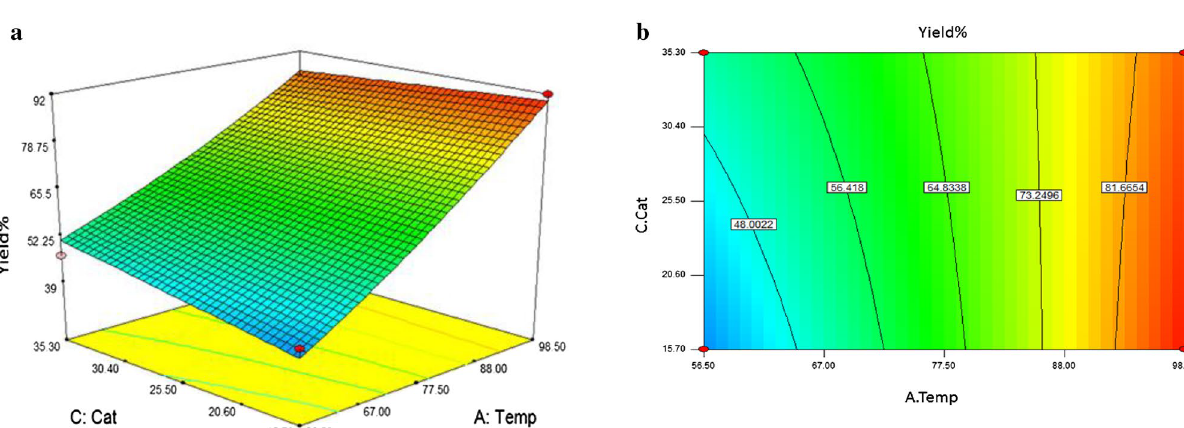
Figure 10. Three-dimensional response surface ( a ) and contour plot for reaction temperature (A) versus catalyst loading (C) ( b ).